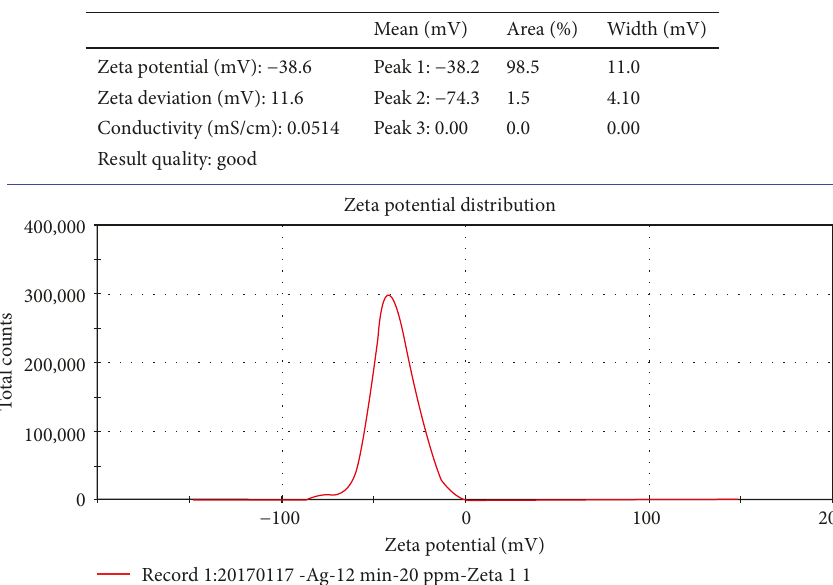
Figure 13: Zeta of aqueous colloid silver (arcing in DW + PVA for 12 min).